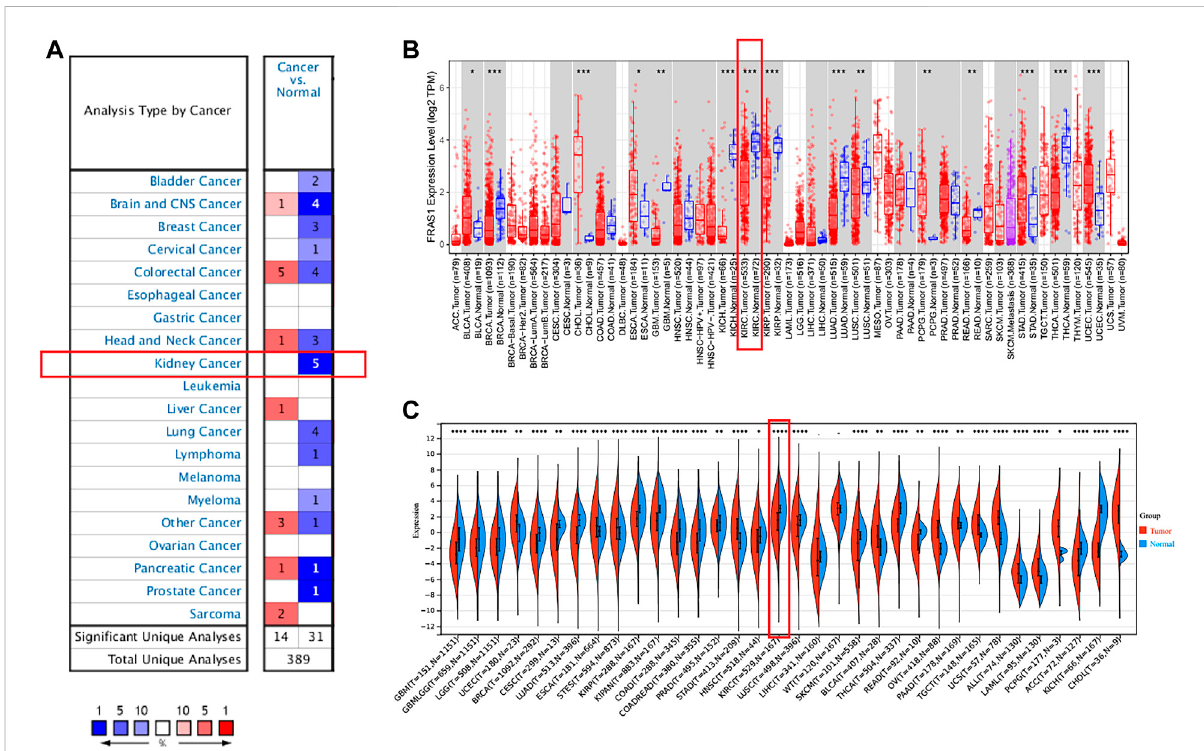
FIGURE 1 Pan-cancer expression analysis of FRAS1 mRNA in human tumors vs. normal tissues. (A) Differential expression of FRAS1 in the Oncomine database. (B) The expression pro fi le of FRAS1 in pan-cancer analysis by TIMER2.0. (C) The expression pro fi le of FRAS1 in pan-cancer analysis from TCGA database and GTEx database. (* p < 0.05, ** p < 0.01, *** p < 0.001).